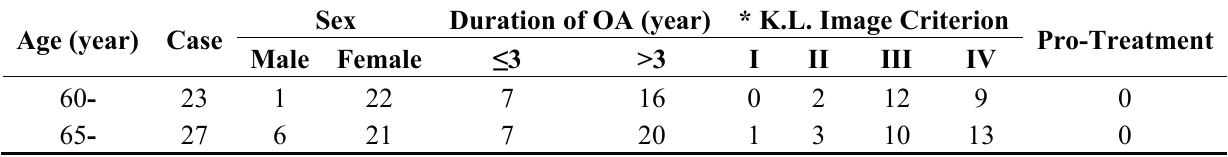
Table 1. Information of osteoarthritis (OA) patients with total knee replacement